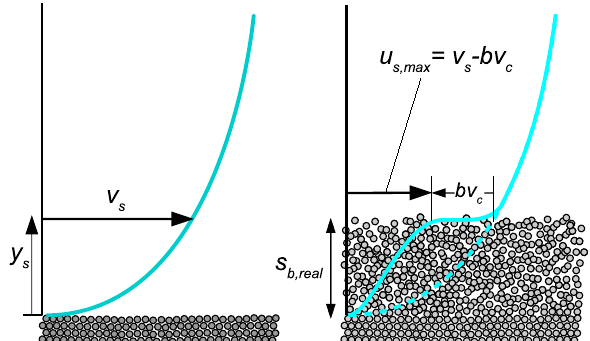
Figure 1. Velocity distribution near bed, schematically. ( Left ): fluid only; ( Right ): fluid and bed-load